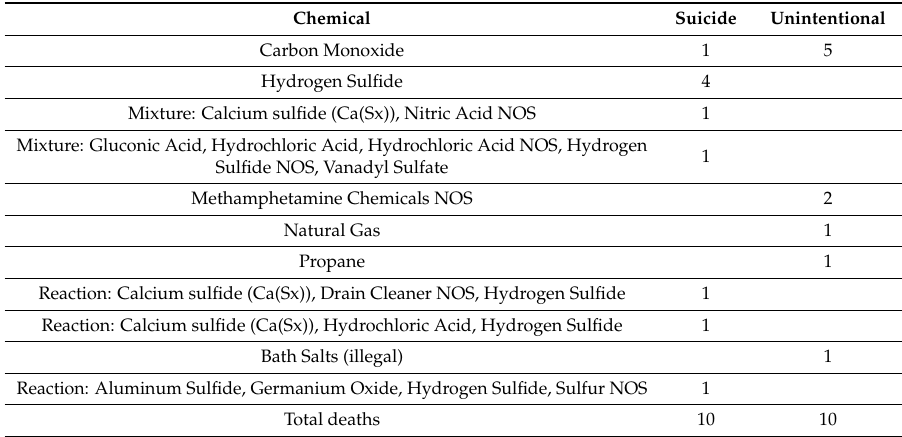
Table 3. Chemicals involved in victim deaths, North Carolina,